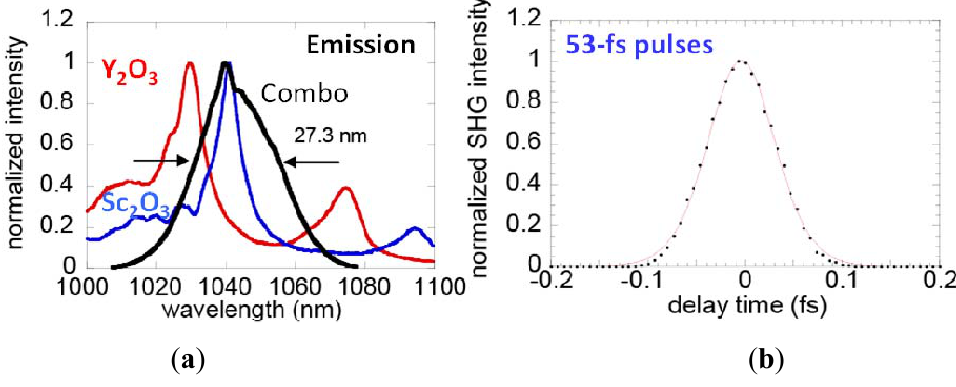
-0.35SrF ceramic compared with a single 2 2